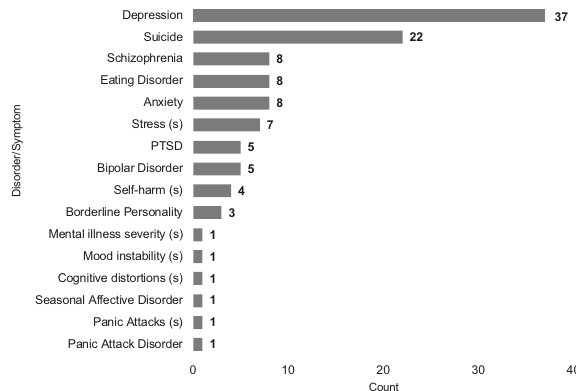
Fig. 3 Publication counts by disorder and symptomatology. In this graph, we display the counts of publications that study speci fi c disorders and